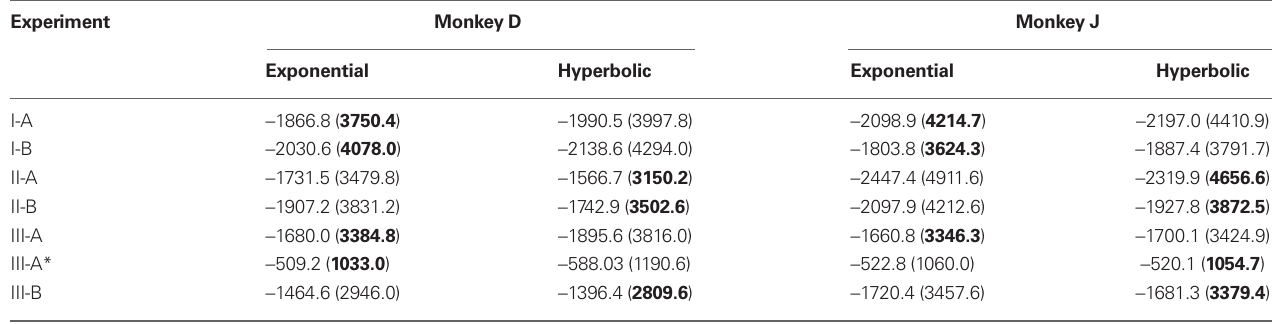
Table 3 | Log likelihood (Bayesian information criterion, BIC) for exponential and hyperbolic discount functions. Experiment